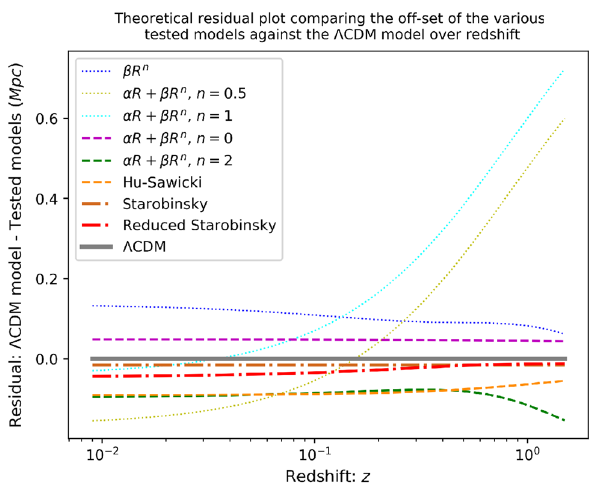
Fig. 9 Theoretical residuals comparing the different tested models against the Λ CDM model. The two most successful models are shown with a “dashed-dot” line, while the models that showed promise, were plotted with “dashed” lines. The unsuccessful models are shown with “dotted”